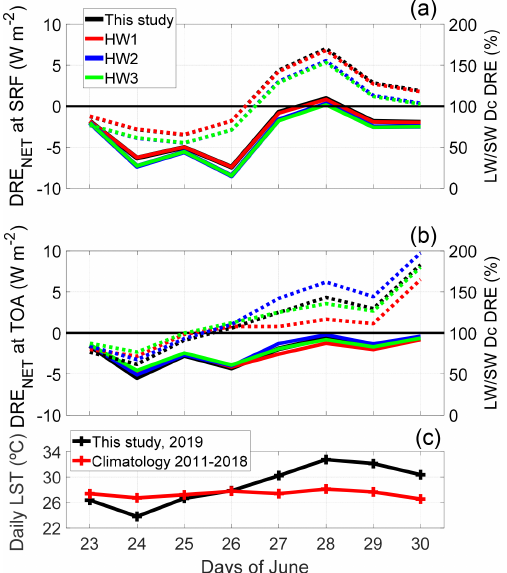
Figure 13. (a) Daily Df and DD DRE NET (left axis) and daily Dc LW / SW DRE ratio (right axis) at SRF; (b) daily Df and DD DRE NET (left axis) and daily Dc LW / SW DRE ratio (right axis) at TOA; (c) daily mean LST. Site: BCN; time period: 23–30 June. The shaded area represents the period during which both SRF and TOA Dc LW / SW DRE ratios cross the 100% threshold.